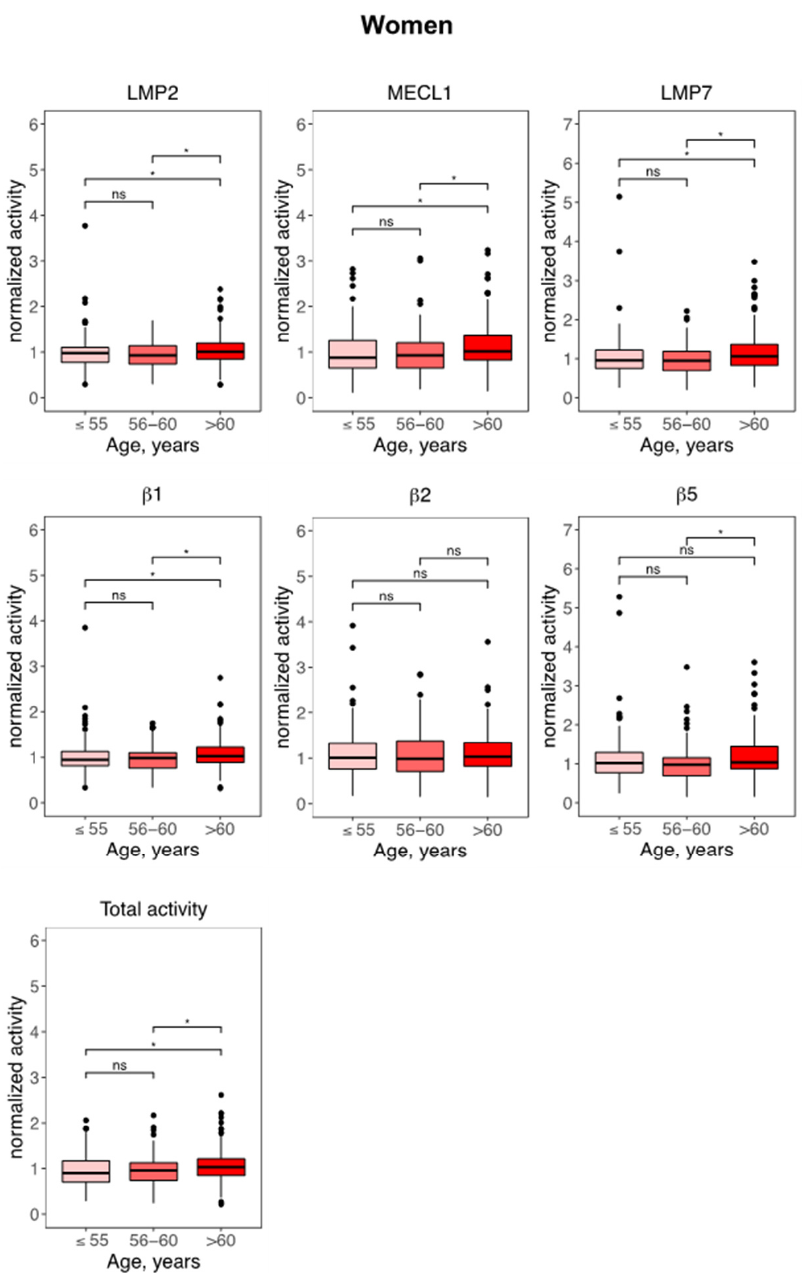
Figure 4. Immunoproteasome activity is distinctly activated in aged women. Activity-based probe (ABP) analysis of proteasome activity in peripheral blood mononuclear cells (PBMC) of female adults in the KORA-FF4 cohort. All samples were normalized to the batch-specific median. Age was categorized into ≤ 55, 56–60 and >60 years of age. Normalized proteasome activities are shown as boxplots of proteasome parameters according to age with median, 1st and 3rd quartile and whiskers indicating +/ − 1.5 *IQR (interquartile range). Differences between groups were tested using pairwise Wilcoxon rank sum test. * = p < 0.05 and ns = non-significant.